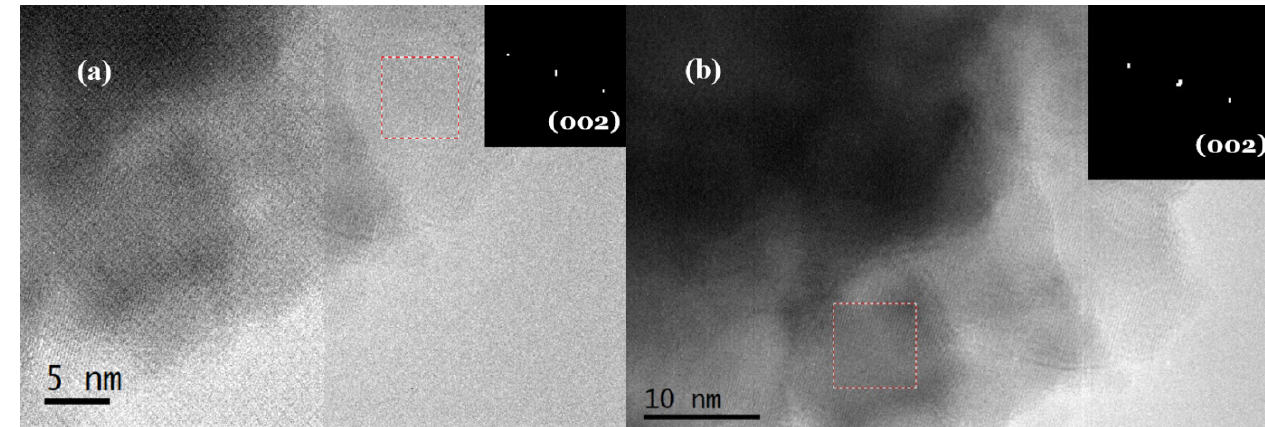
Figure 9. Micrographs of ZnO:Al film deposited on NaCl substrate and subsequently detached from it. The indexing of the electron pattern has been carried out on the areas delimited by a dotted line.